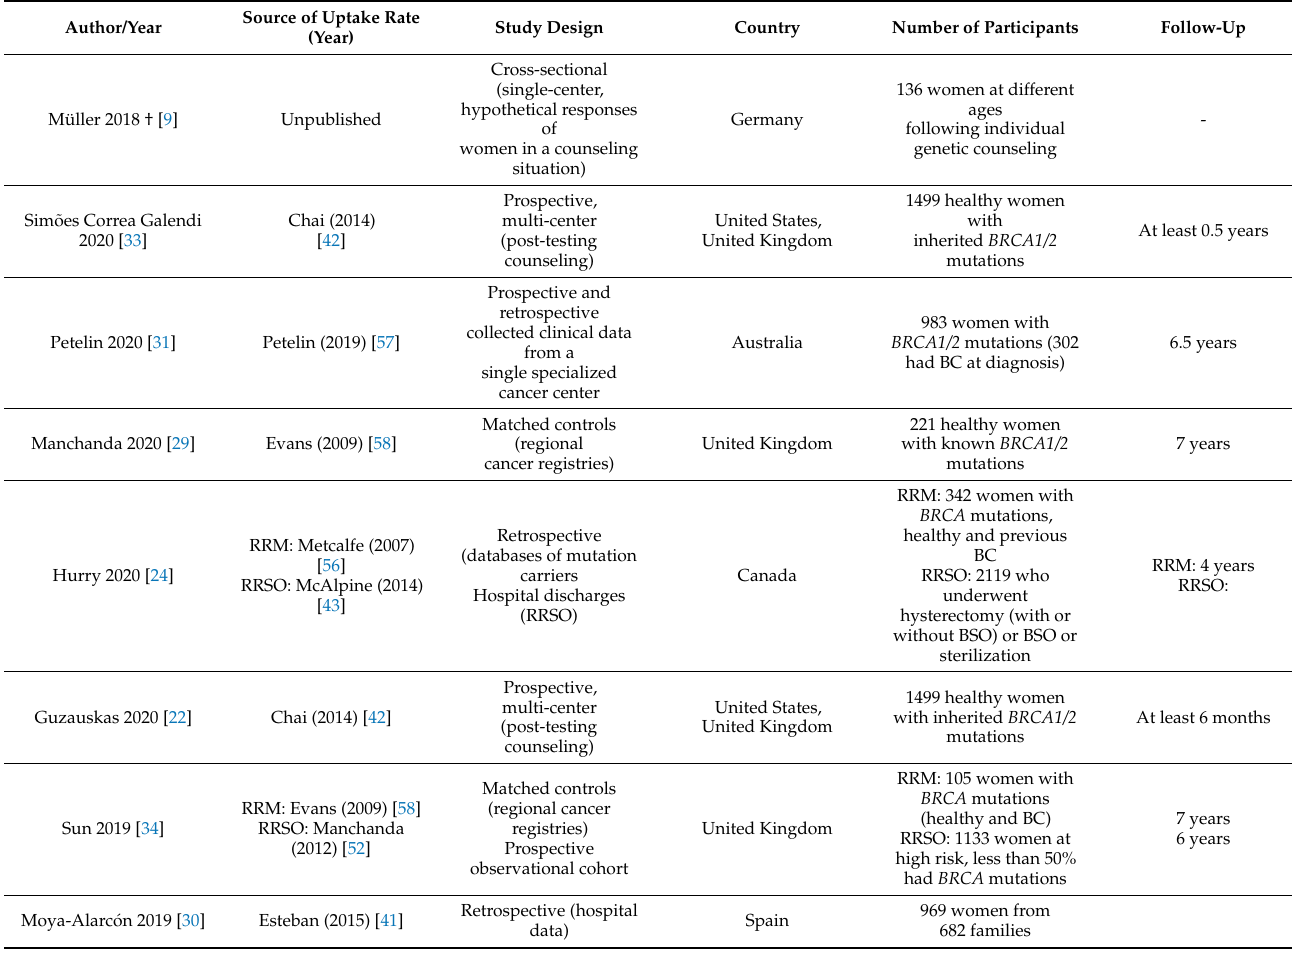
Table 2. Sources of uptake rates cited by the included health economic